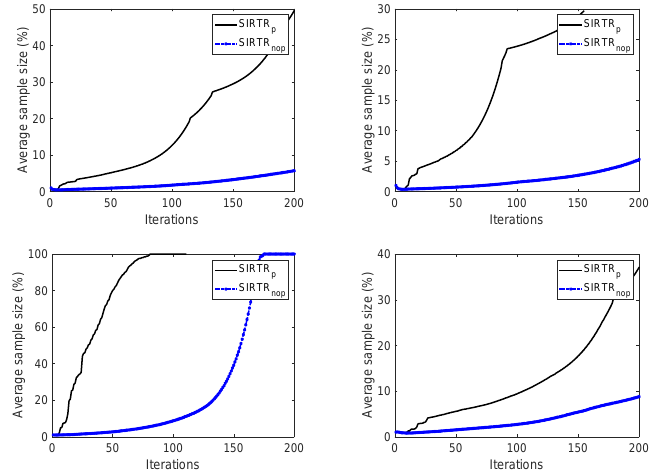
Figure 2. Average percentage ratio of the sample size N k + 1 over the data set size N versus iterations. Top row : a8a ( left ) and a9a ( right ). Bottom row : mnist ( left ) and phishing ( right